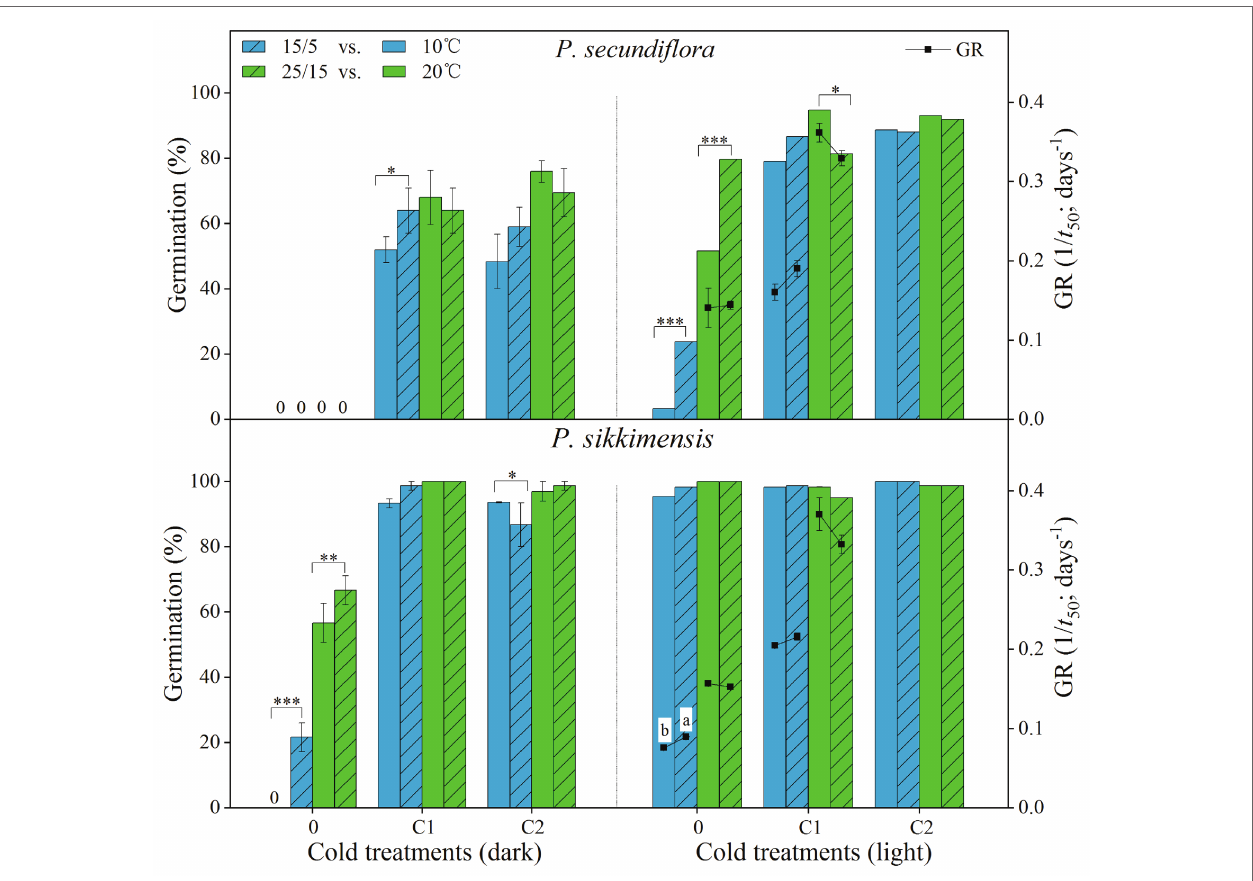
FIGURE 4 | Effect of alternating and corresponding constant temperatures (15/5 vs. 10 and 25/15 vs. 20 ° C) on final germination percentage and germination rate (GR, 1/ t 50 ) of Primula secundiflora and Primula sikkimensis under each cold treatment (0, control; C1 and C2 cold stratification at 1 ° C in light for 4 and 8 weeks, respectively). Error bars indicate SE for three replicates of 20 seeds. 0, no germination with this treatment. ∗ p < 0.05; ∗∗ p < 0.01; and ∗∗∗ p <0.001, respectively. Different letters indicate significant differences in germination rate at p < 0.05, and the unmarked bars and boxes show no difference between alternating and corresponding constant temperatures.